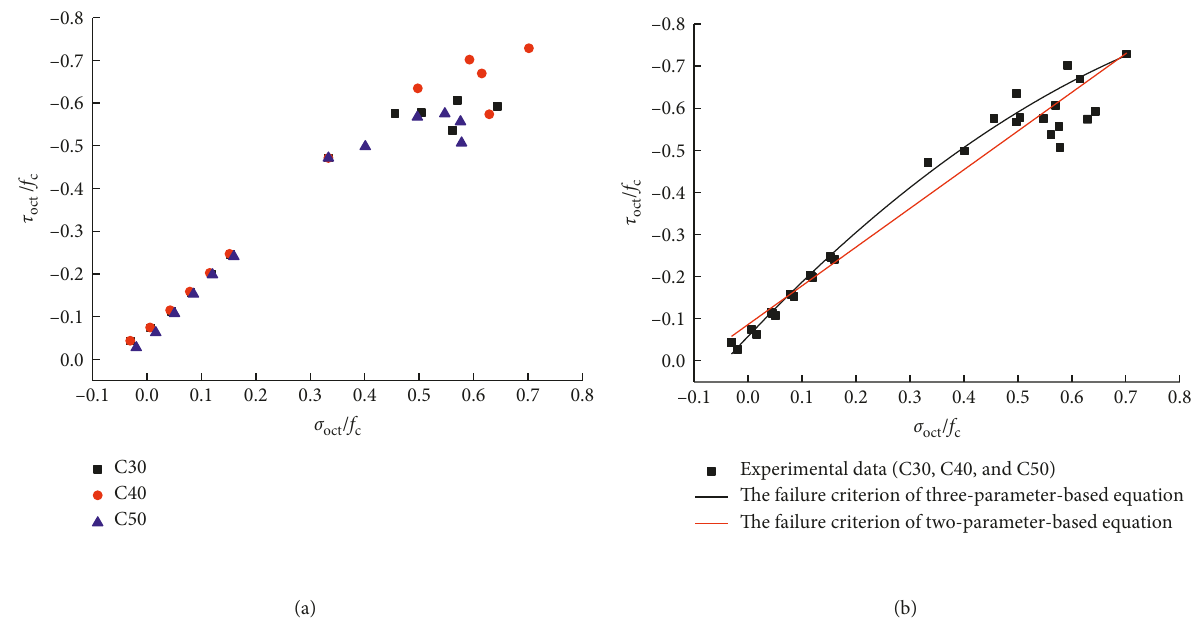
Figure 11: The new failure criterion based on octahedral stress space. (a) Experimental data based on octahedral stress space. (b) Two different kinds of failure